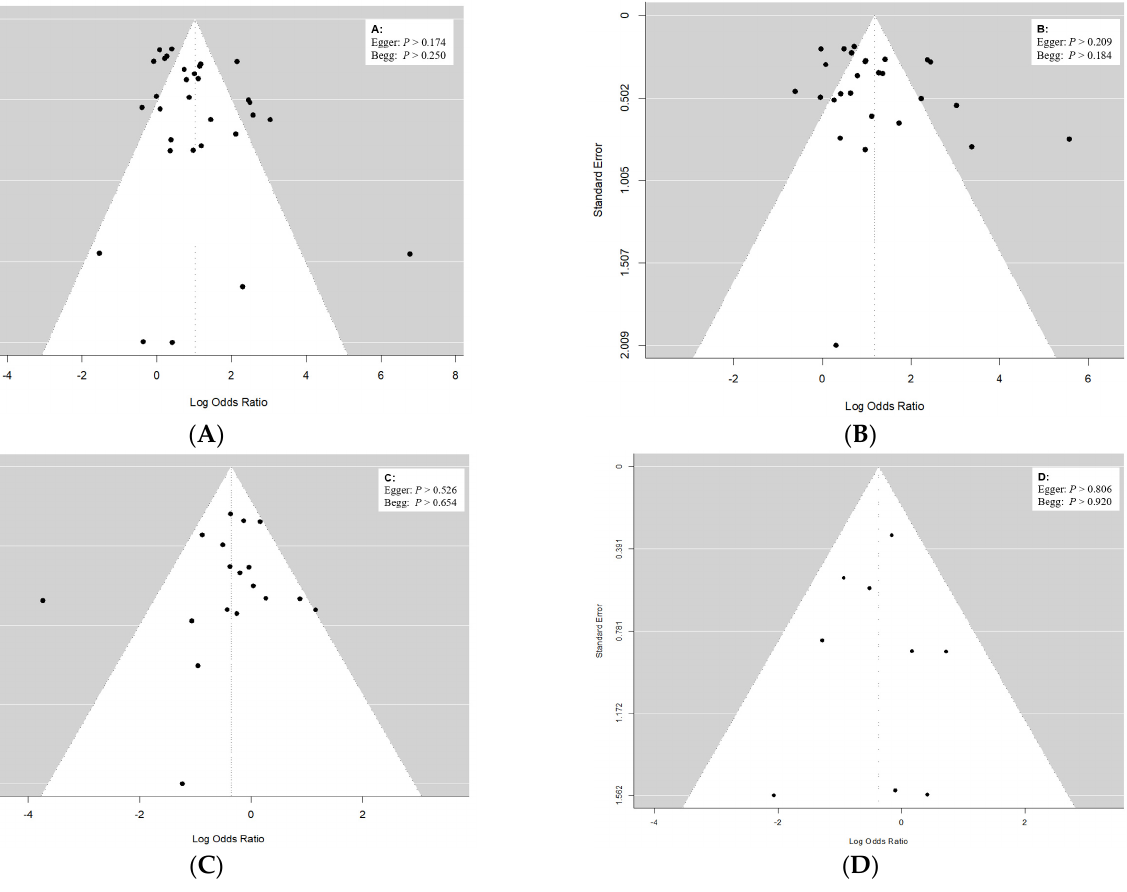
Figure 2. Funnel plots for publication bias tests (( A ), rpoB ; ( B ) , katG ; ( C ), inhA ; ( D ), oxyR − ahpC